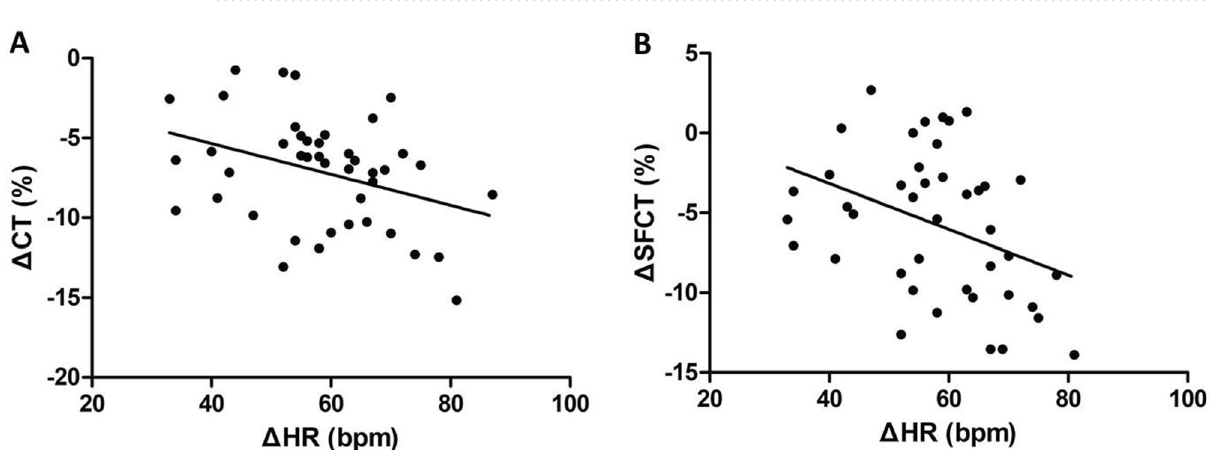
Figure 4. Scatter plot of ΔCT% against ΔHR ( A ) and scatter plot of ΔSFCT% against ΔHR ( B ) of myopic eyes. CT mean choroidal thickness; SFCT subfoveal choroidal thickness; HR heart